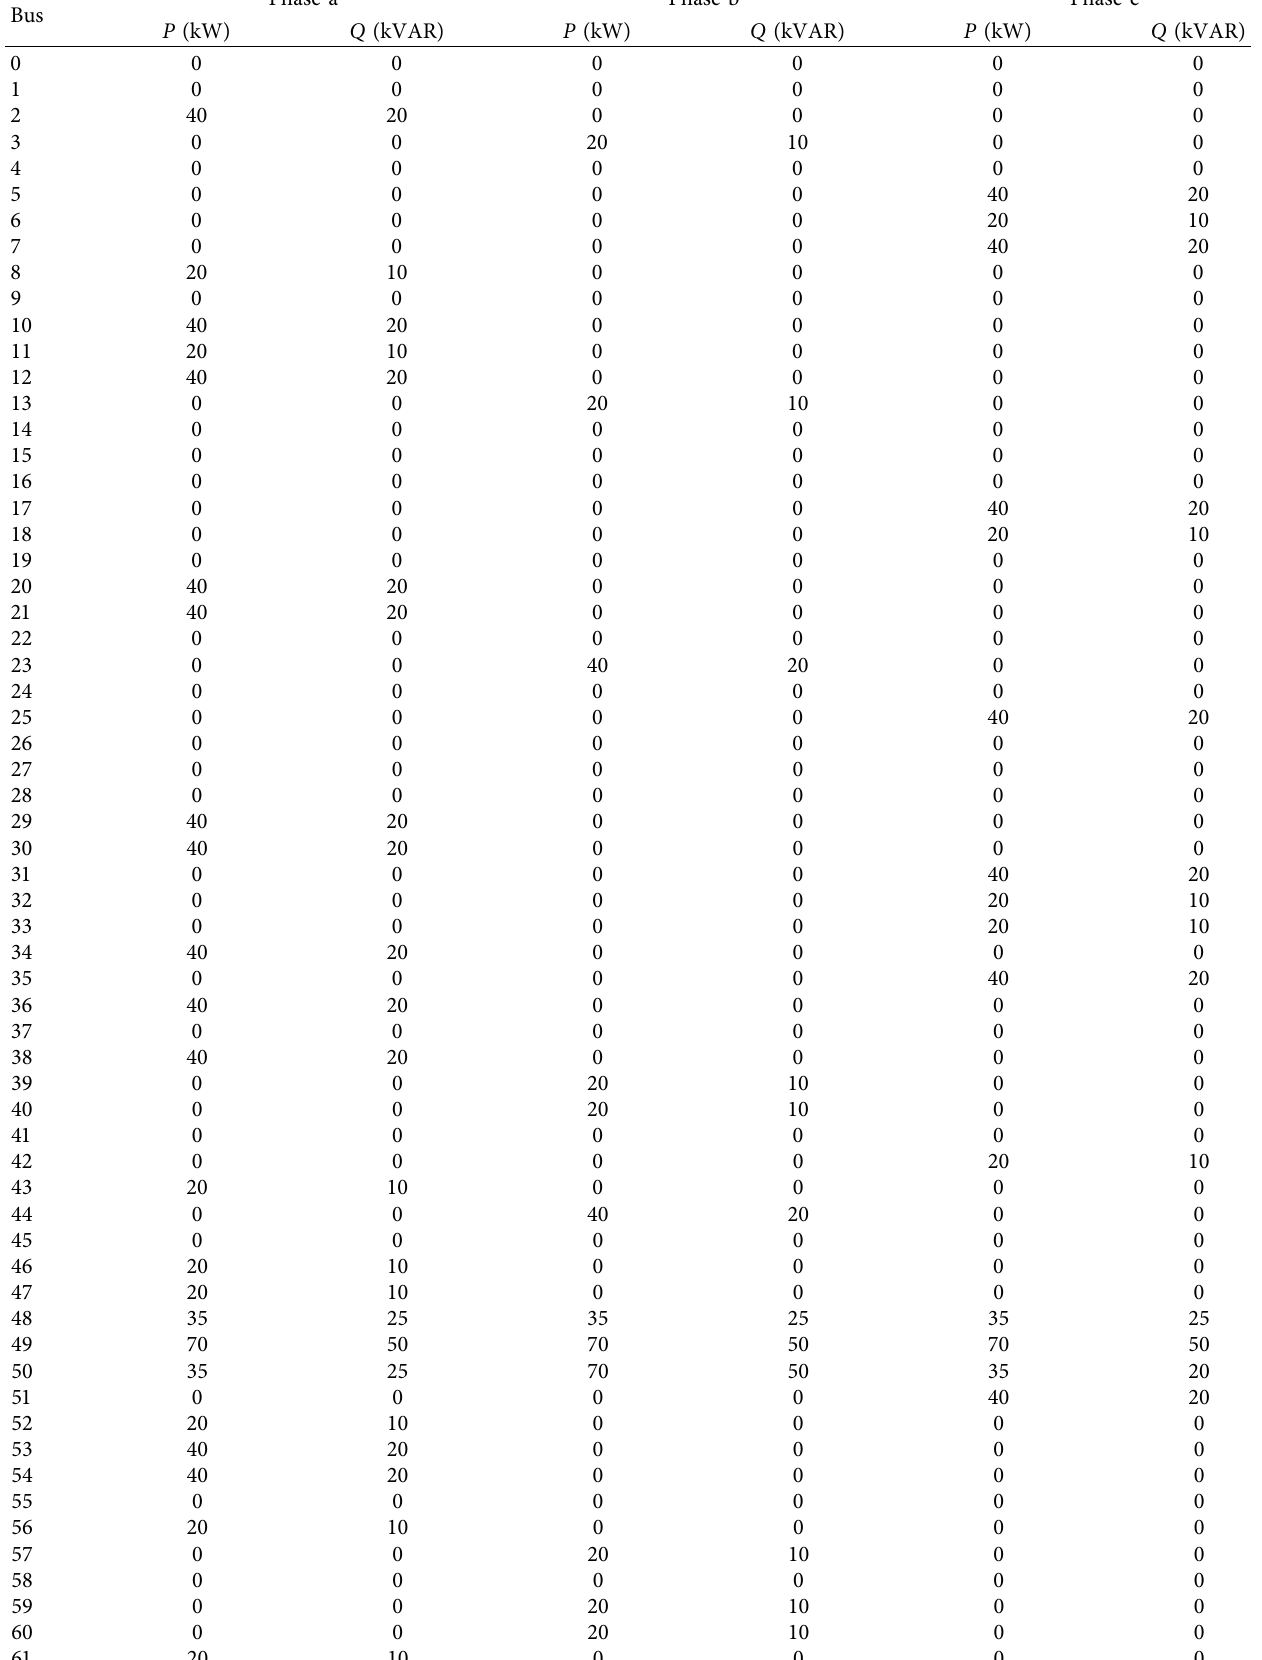
Table 9: Loads of 123-bus